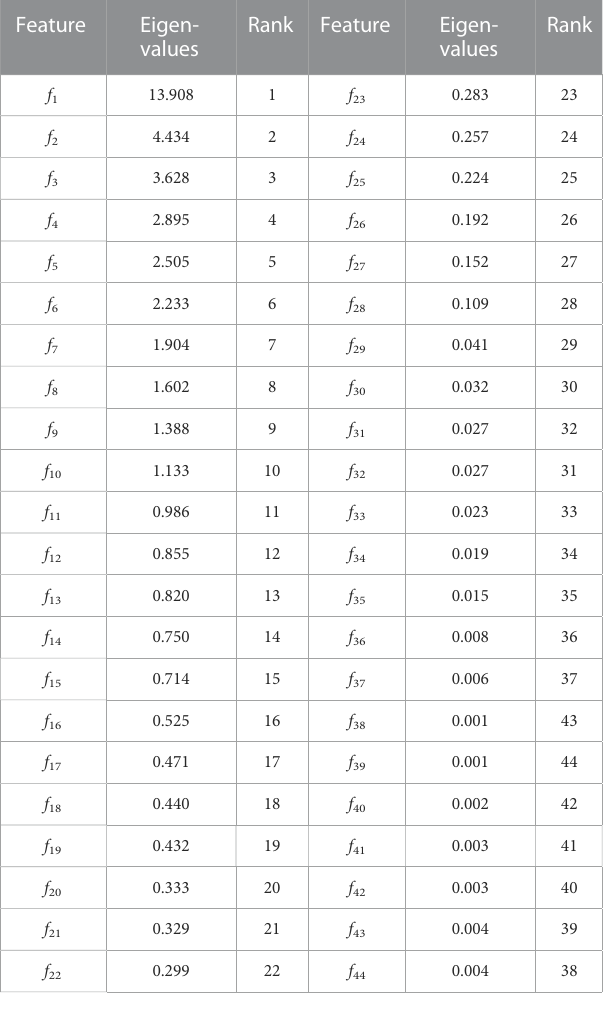
TABLE 9 Demonstration of discriminant features among proposed features, Shannon entropy, Hurst exponent, modi fi ed Shannon entropy and fractal dimension